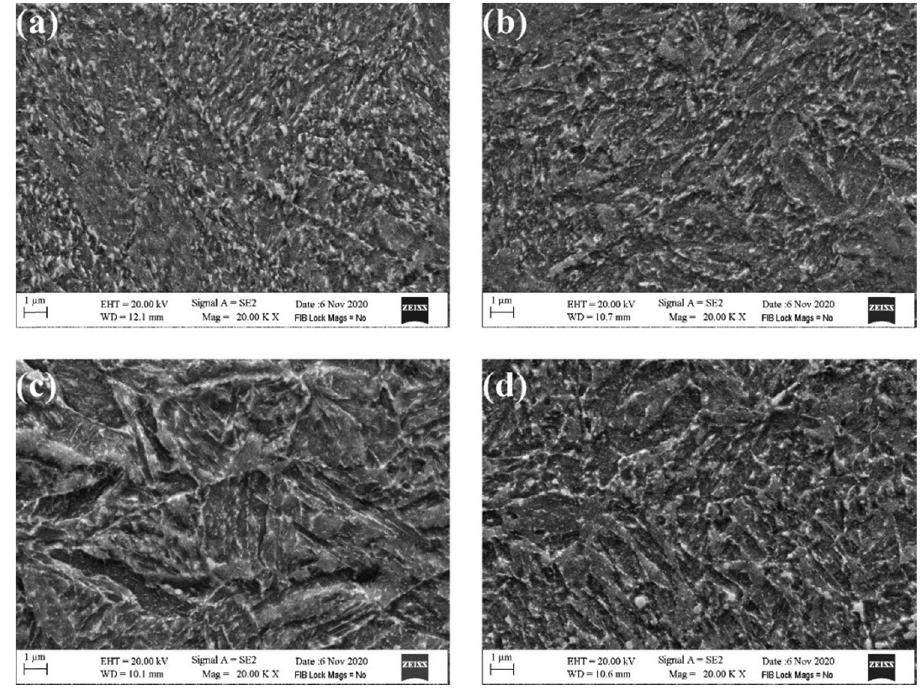
Figure 5: The tempered microstructure of the two steels by SEM at 600°C for di ff erent tempering times: ( a ) 2 h - 5CrNiMoV, ( b ) 2 h - 5CrNiMoVNb, ( c ) 24 h - 5CrNiMoV, and ( d ) 24 h -